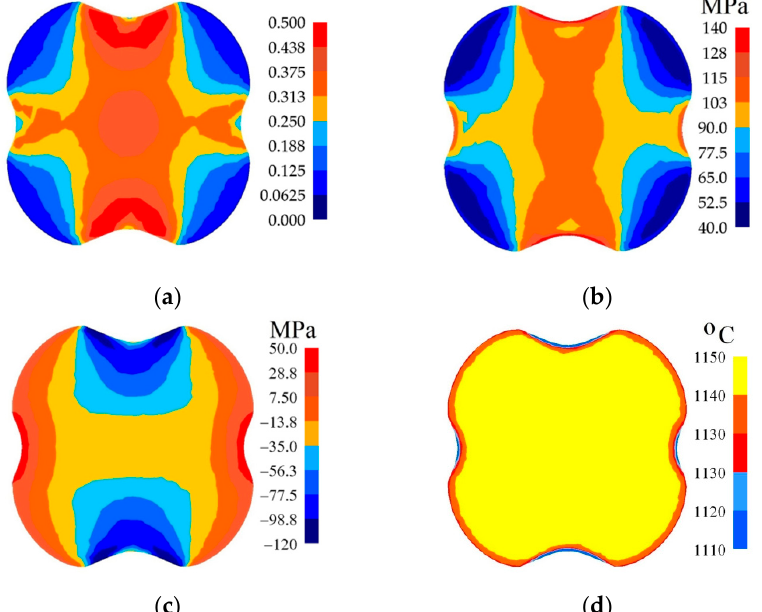
Figure 7. Distribution of the effective strain ( a ), effective stress ( b ), mean stresses ( c ), and temperature ( d ) on the cross-section of the workpiece in the course of forging in convex anvils after the second pass ( α c = 135°, ε c = 0.22).